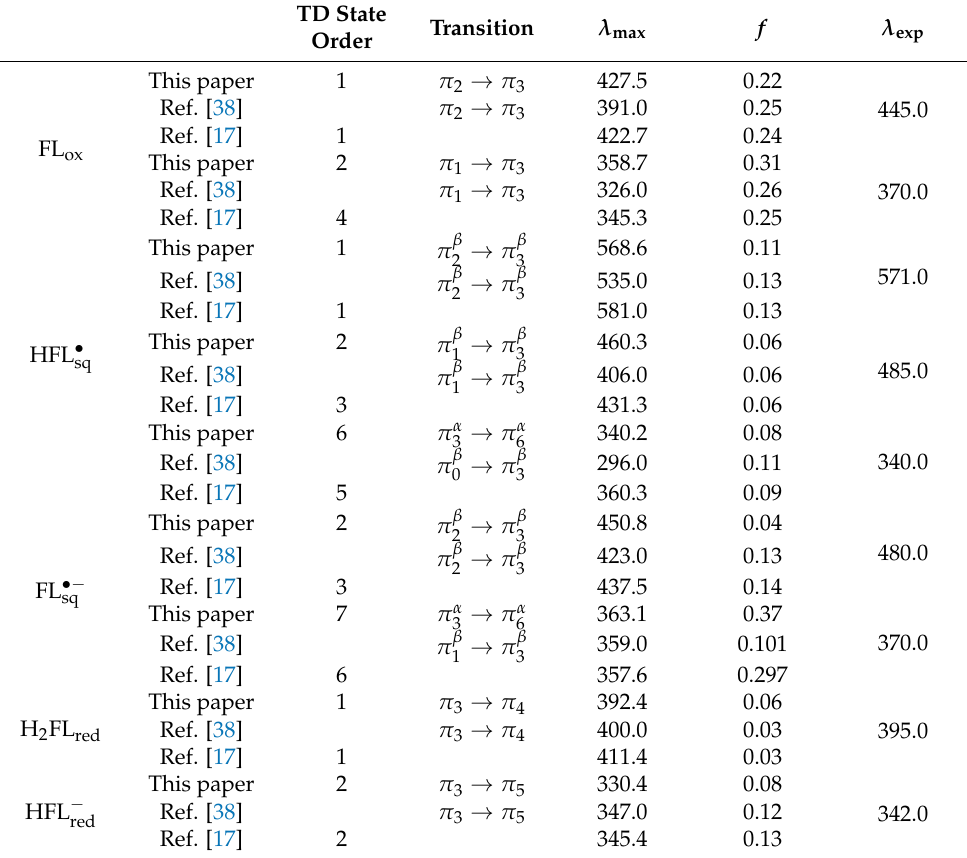
Table 1. Comparison of absorption spectra of flavin between this paper and previous theoretical studies. Experimental results for FL ox were taken from Refs. [15,39]; for HFL • sq and FL •− sq from Ref. [40]; and for H 2 FL red and HFL − from Ref. red